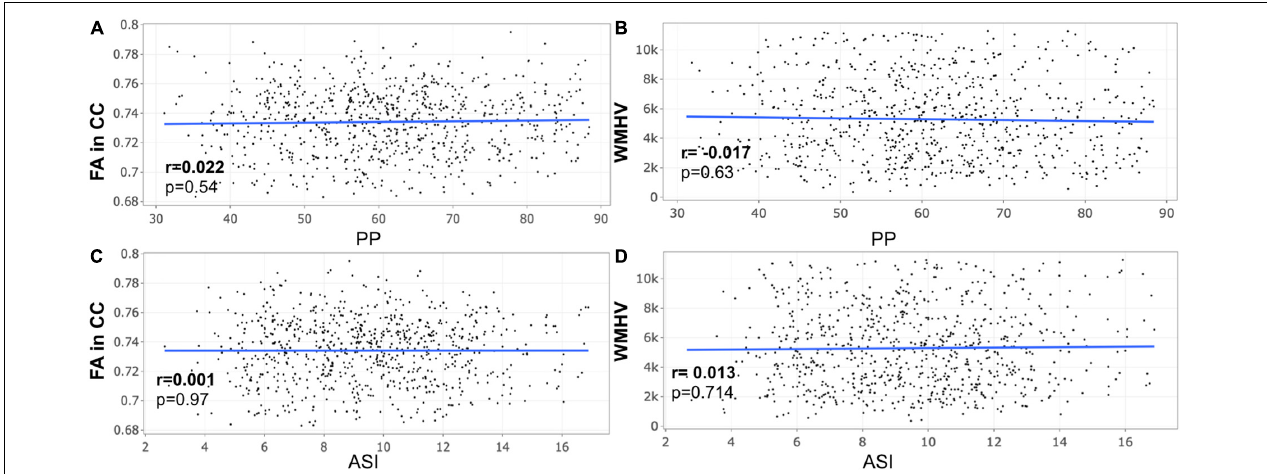
FIGURE 4 | Scatter plot for partial correlation analysis of either pulse pressure (PP) or stiffness Index (ASI) with the fractional anisotropy of the corpus callosum (FA in CC) or the white matter hyperintensity volume (WMHV) in 788 participants over 75 years old. Significant p -values are in bold (adjusted threshold with FDR was 0.0125). Covariates included is sex. An additional analysis was performed with both age and sex as covariates showing similar results. (A–D) p values >